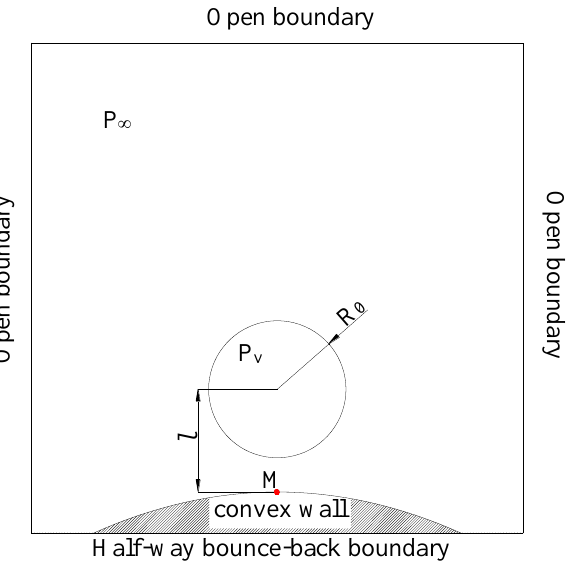
Figure 9. Computational layout for the cavitation bubble collapse near a straight wall.